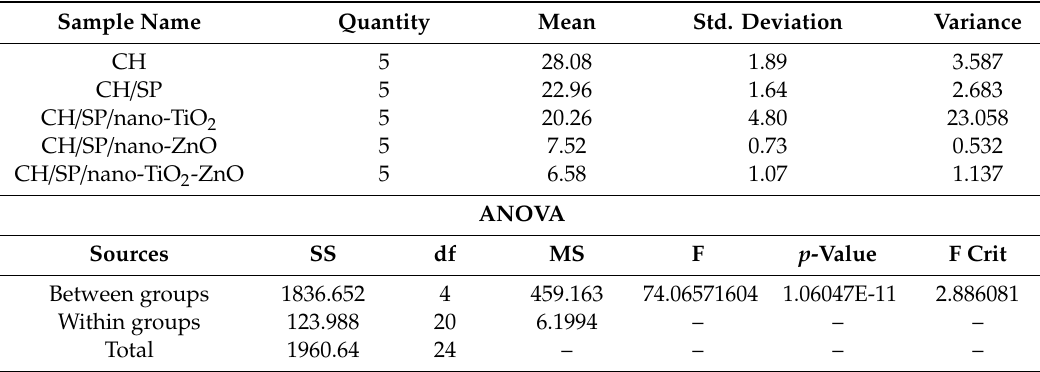
Figure 5. Flame burning tendency of ( a1 , a2 ) original wood; ( b1 , b2 ) CH coated sample; ( c1 , c2 ) CH/SP coated sample; ( d1 , d2 ) CH/SP/nano-ZnO sample; ( e1 , e2 ) CH/SP/nano-TiO 2 sample; and ( f1 , f2 ) CH/SP/nano-TiO 2 -ZnO sample. Table 3. Correlation data of self-extinguishing time and one-way